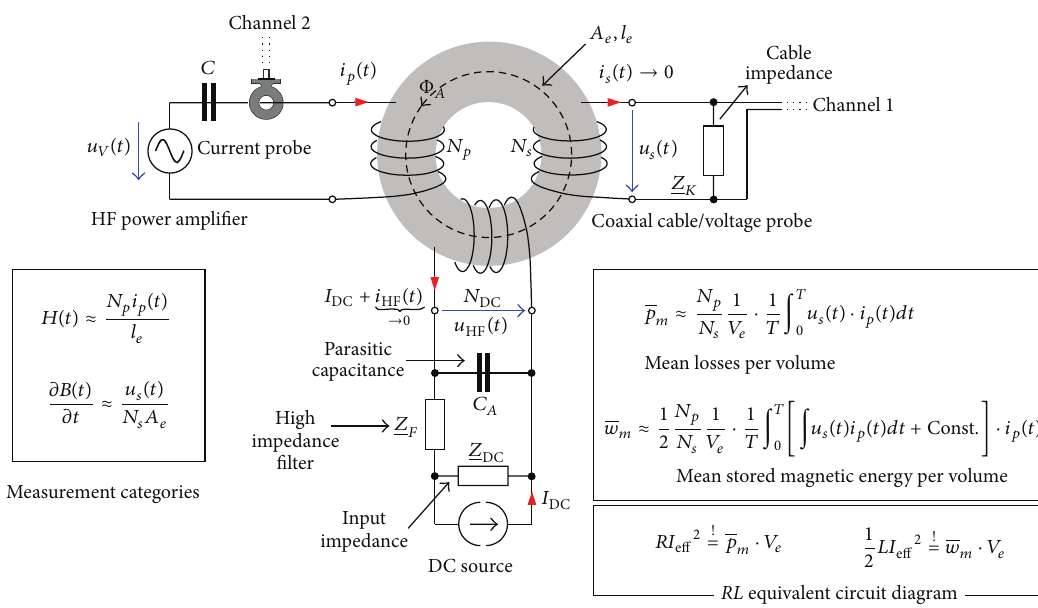
Figure 3: Equivalent test set-up to determine the material parameters according to the standards